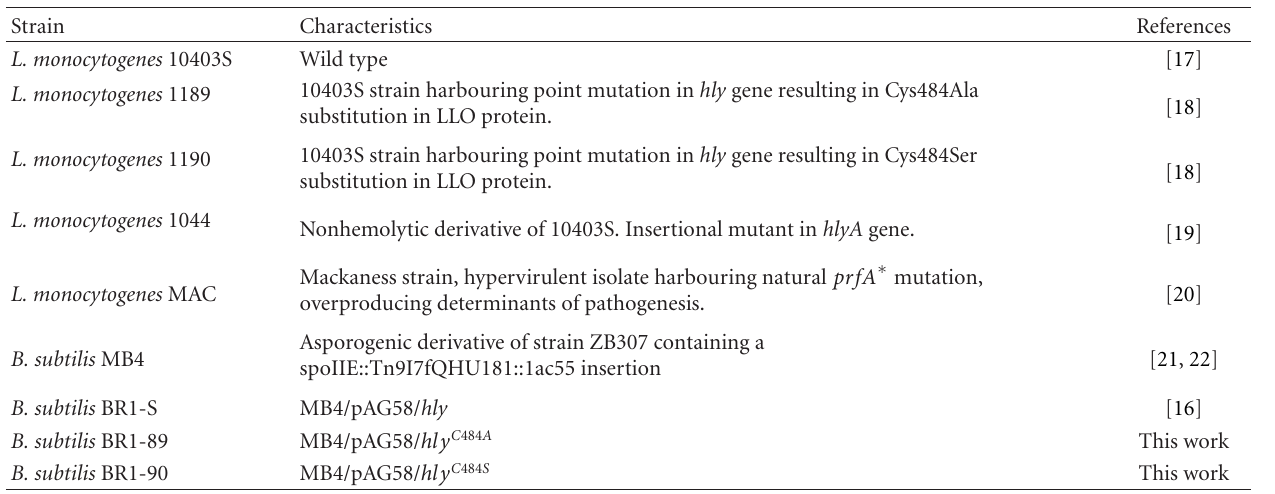
Table 1: List of bacterial